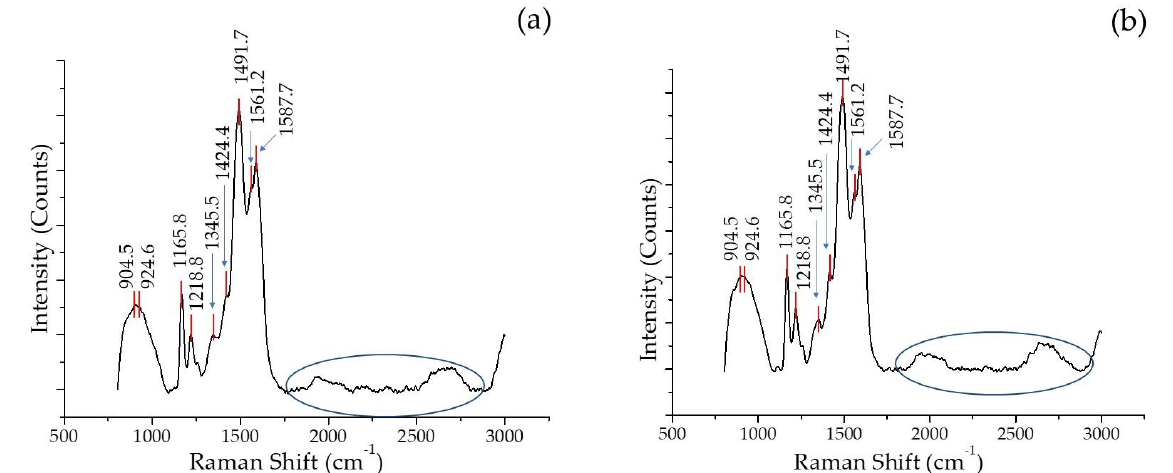
Figure 5. Laser Raman spectra of the ( a ) SPani and ( b ) SPani-AC composite. The spectra display peaks characteristic of Pani, viz., the bands located at 1588 cm −1 are assigned to C-C single bond and double bond stretching in the quinine type ring. The bands appearing at 1345 cm −1 and 1491 cm −1 correspond to C-N + and C=N stretching